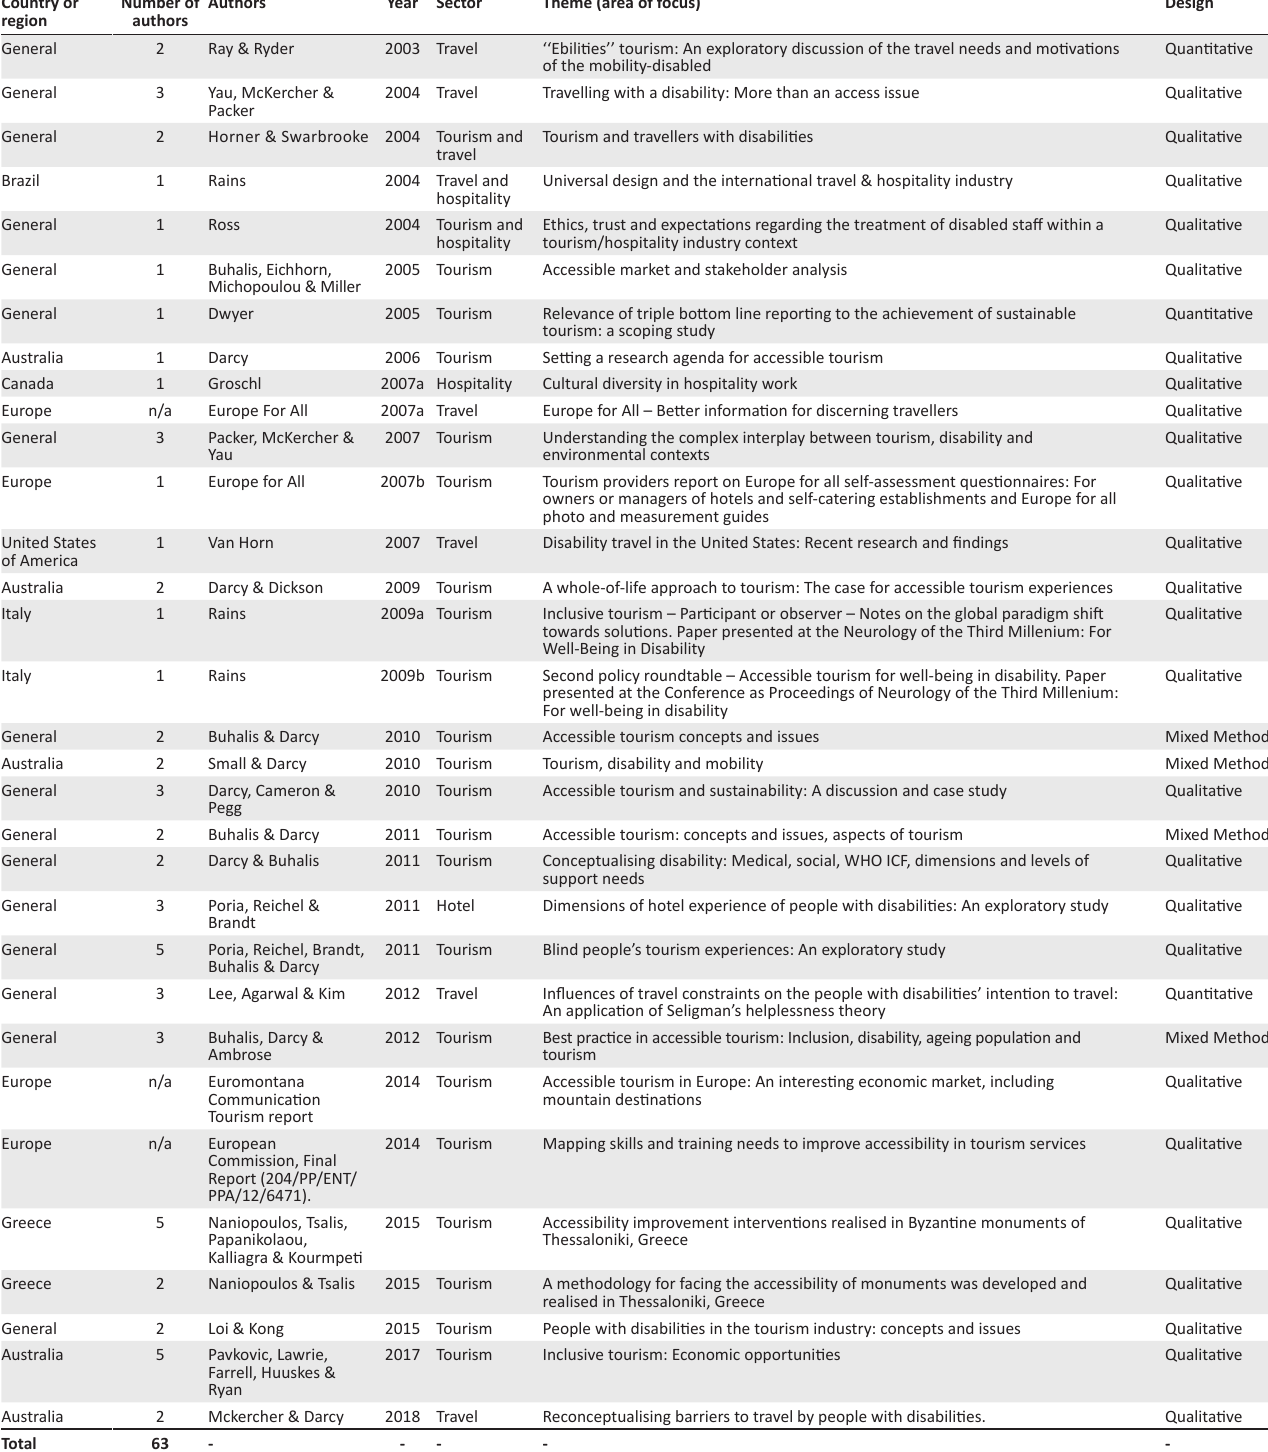
TABLE 9: Results of general tourism literature on disability and impairment issues (from 1990–2018) . Country or